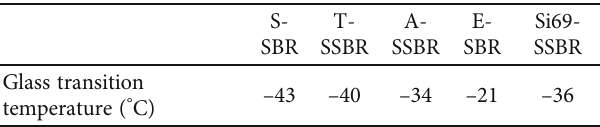
Figure 9: The variation in tan ( δ ) with the temperature for the cured samples. Table 7: The glass transition temperature of the